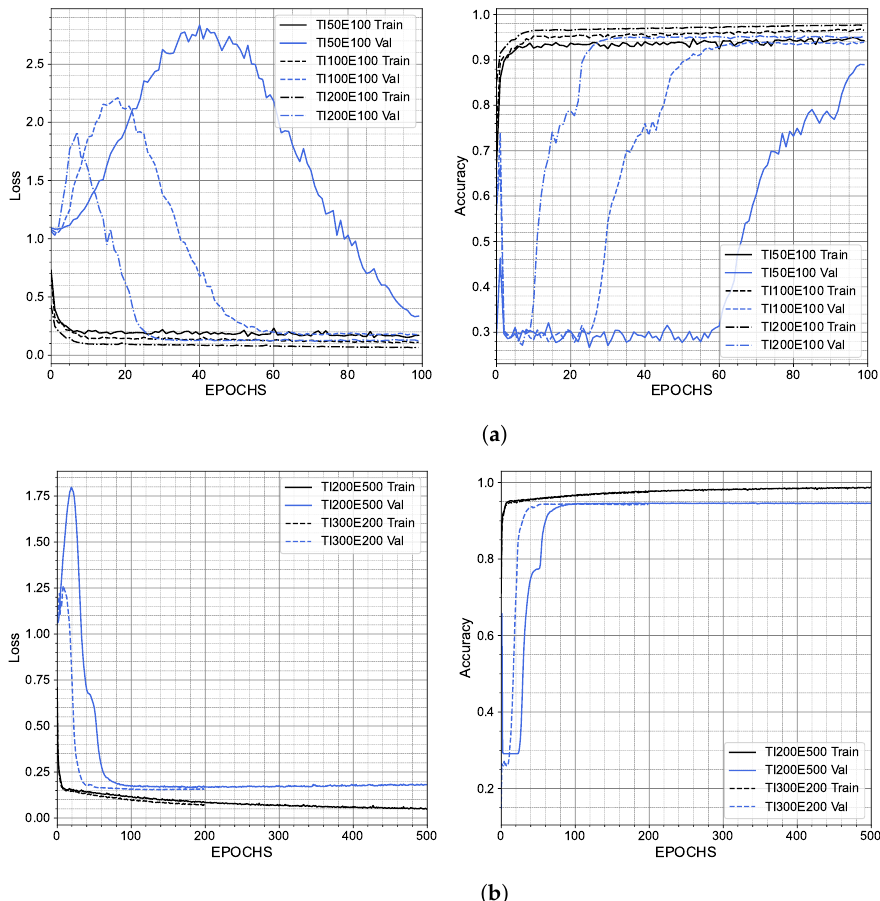
Figure 6. Accuracy and loss for the training of the U-Net, ( a ) for different numbers of training images, and ( b ) for optimized models.